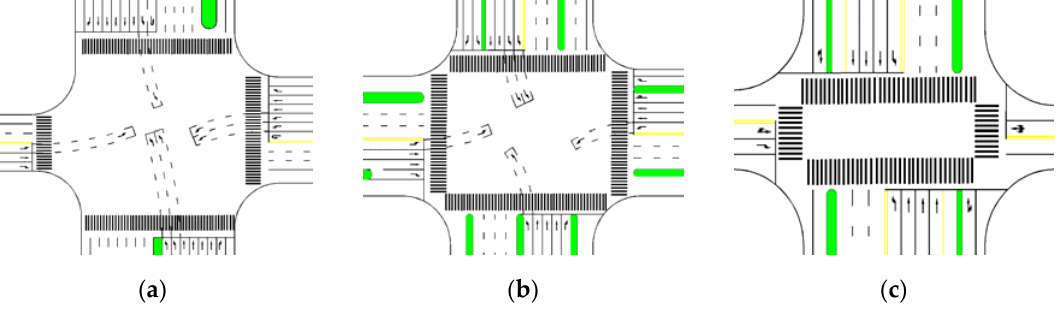
Figure 5. Channelization of signalized intersections: ( a ) scenario 1 intersection; ( b ) scenario 2 intersection; ( c ) scenario 3 intersection.